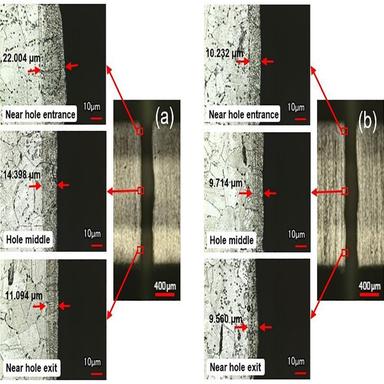
Etched through-hole section analysis for comparing recast layer characteristics generated under different co-axial argon pressures of (a) 0.1 MPa and (b) 0.2 MPa using 50 laser pulses.